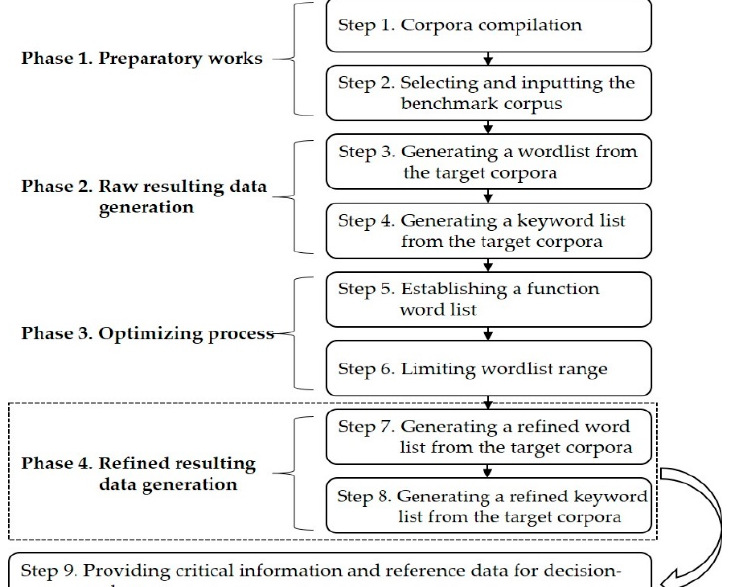
Figure 3. The flow chart of the proposed approach.